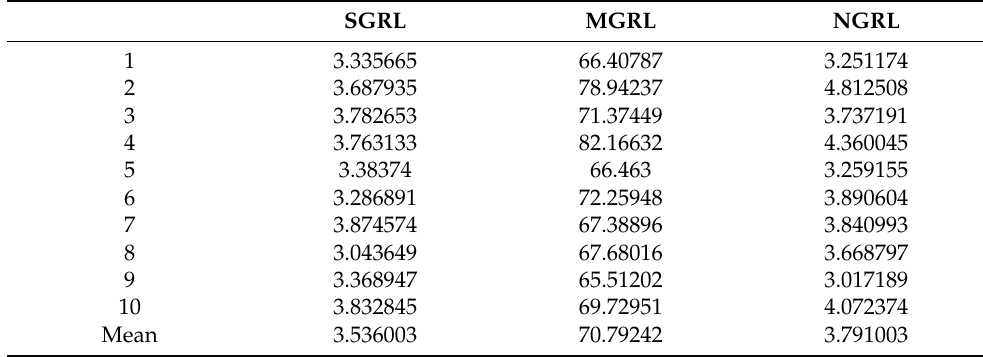
Table 4. Training time statistics (ten experiments for each algorithm; time unit is